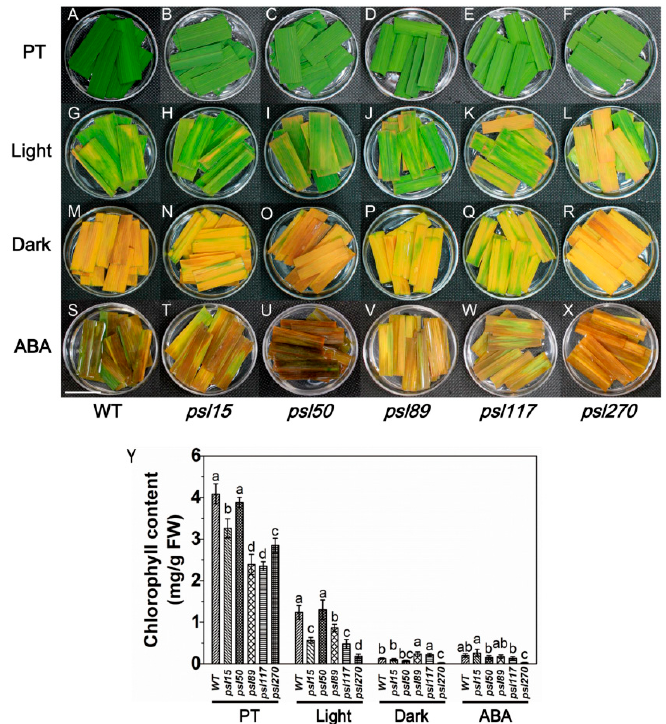
Figure 4. Darkness- and abscisic acid (ABA)-induced leaf senescence. ( A – X ) Detached top second leaves from the WT and five mutants at the tillering stage were incubated with continuous light (H 2 O), darkness (H 2 O), and 200 μ M ABA (continuous light) at 28 °C for 5 d. PT, Pretreatment. Scale bar = 2 cm. ( Y ) Chlorophyll content of the detached top second leaves at tillering stage. Error bars indicate means ± SD ( n = 3). Different letters indicate a statistical difference at p ≤ 0.05 by Duncan’s test.